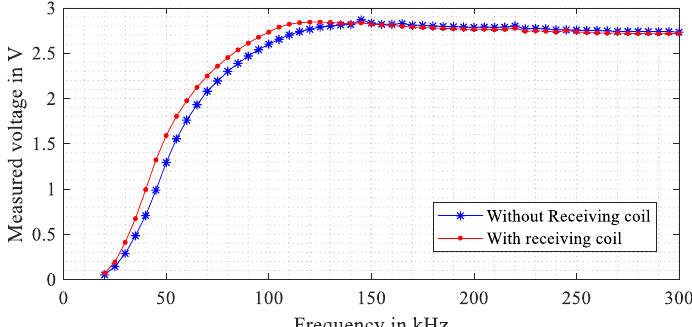
Figure 5. Measured voltage detection for different working frequencies [Blue] voltage without receiving coil 𝑉𝑁𝑂 − 𝑅𝑒𝑐𝑒𝑖 [red] detection with receiving coil V Recei .